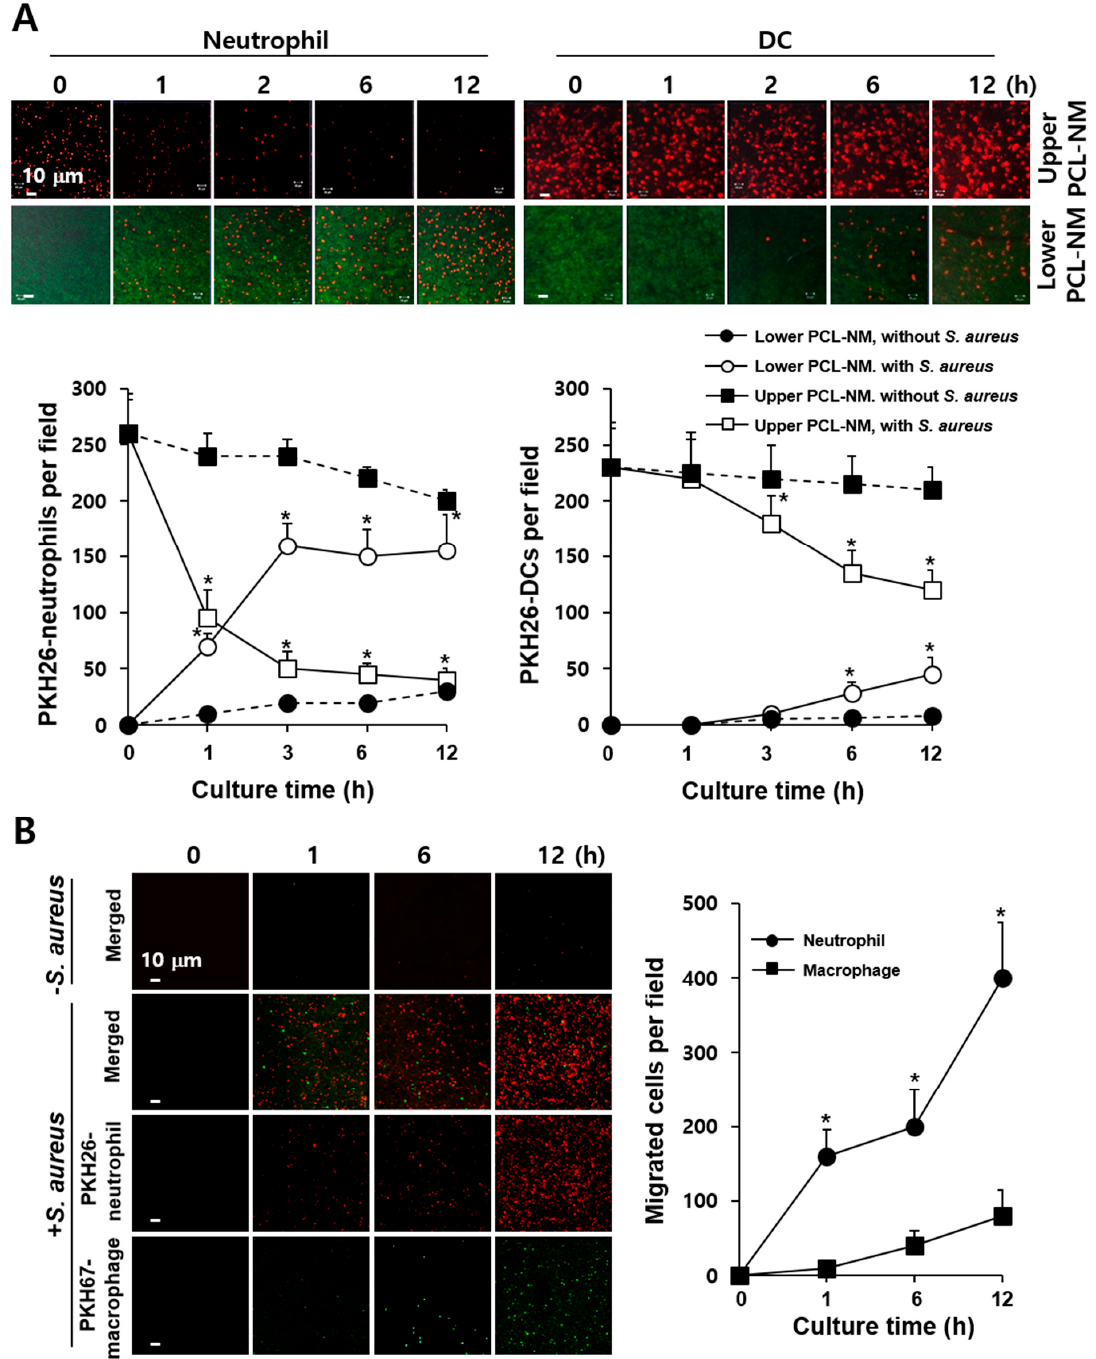
Figure 4. Migration of phagocytes to S. aureus in the PCL-NM-based two-layer culture system. ( A ) PKH26-labeled BM- derived neutrophils and DCs (1 × 10 5 ) and PKH67-labeled S. aureus (1 × 10 7 CFU) were seeded and cultured in the upper and lower PCL-NMs, respectively, for the indicated times ( n = 4). The graphs depict the numbers of red-fluorescent spots ■ detected in the upper ( , □ ) and lower ( ● ○ , ) PCL- ■ ○ NMs when bacteria were absent ( ● , ) or present ( , □ ) in the lower PCL-NM. Data are presented as means ± SDs ( n = 4). Asterisks (*) denote significant differences compared to culture without bacteria ( p < 0.05). ( B ) PKH26-labeled peritoneal neutrophils (1 × 10 5 ) and PKH67-labeled peritoneal macrophages (1 × 10 5 ) were seeded in the upper PCL-NM and S. aureus (1 × 10 7 CFU) was seeded in the lower PCL-NM. Phagocytes in the upper PCL-NM were cultured in the presence (+ S. aureus ) or absence ( − S. aureus ) of bacteria in the lower PCL-NM for the indicated times ( n = 3). The graphs depict the numbers of red- (Neutrophil) and green- (Macrophage) fluorescent spots